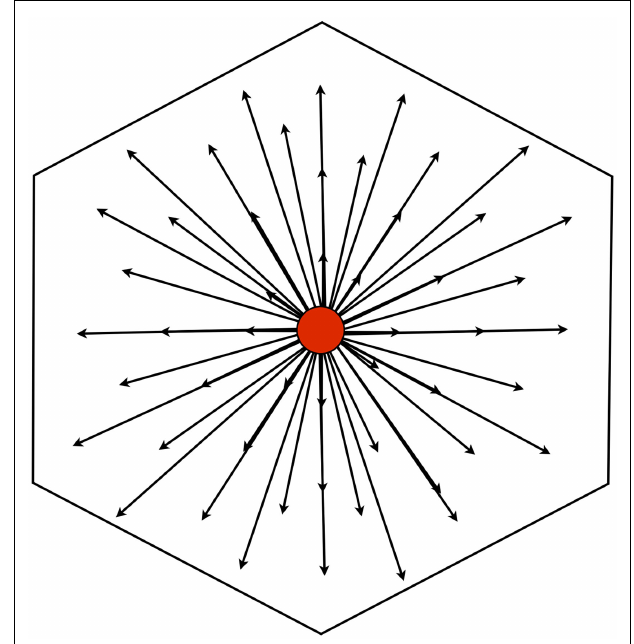
FIGURE 5 |All of the shortest interbump vectors (SIVs) emanating from a grid bumpA will describe a hexagonal tile with grid bumpA at the center. The horizontal width of a hexagonal tile is the grid scale; the side length is (grid scale)/[square root (3)]; the longest SIV is (grid scale)/[square